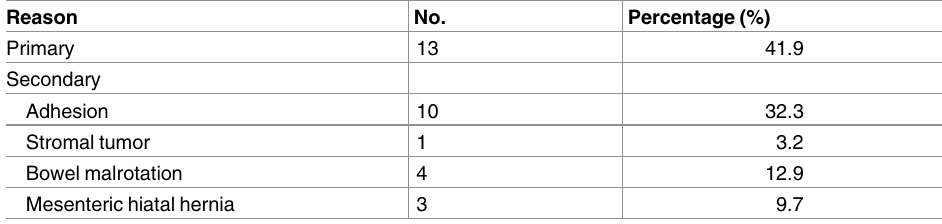
Table 1. Categorization of the small bowel volvulus.